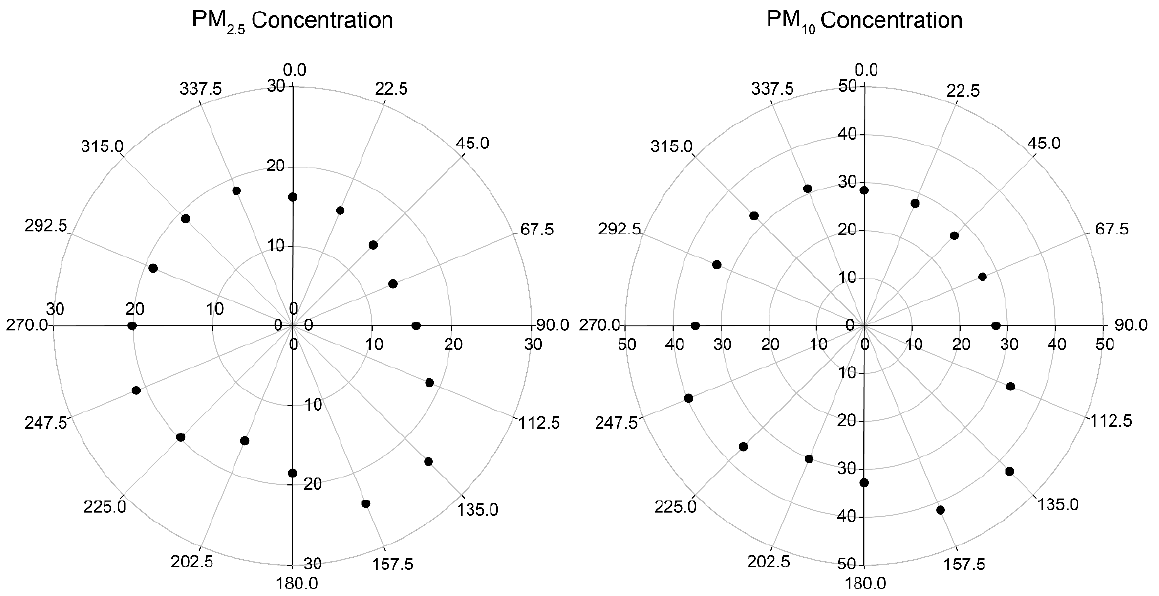
Figure 2. Annual average concentrations of particulate matter with an aerodynamic diameter ≤ 2.5 µ m (PM2.5) ( left ) and particulate matter with an aerodynamic diameter ≤ 10 µ m (PM10) ( right ) according to wind direction (see Supplementary Materials Table S1 for more detail).